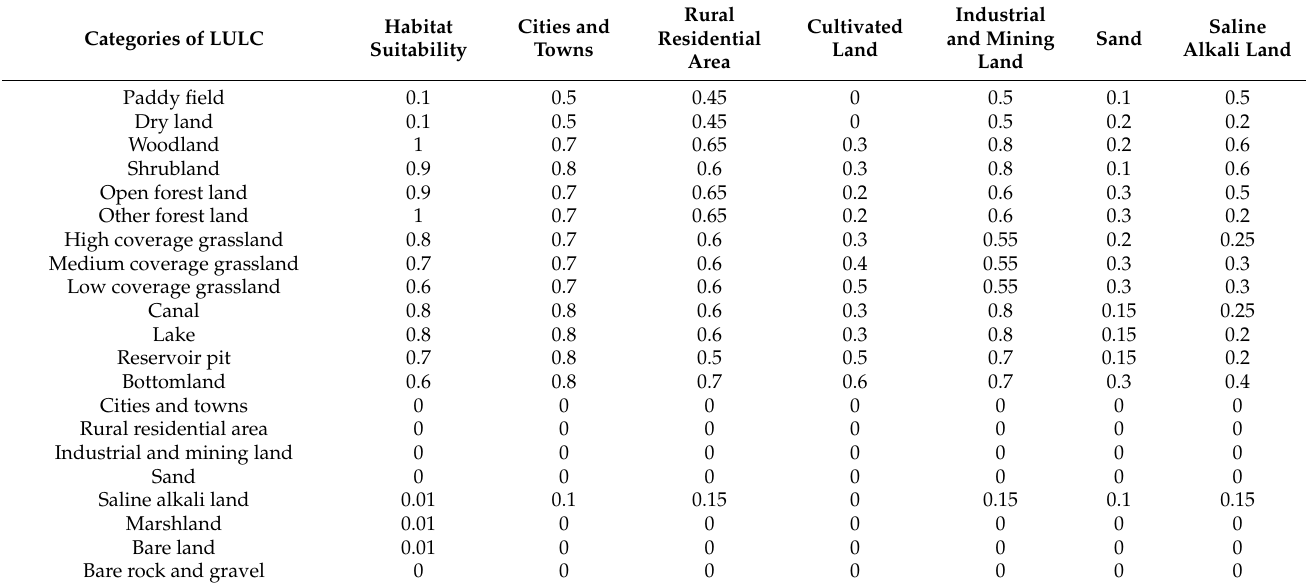
Table 5. Habitat suitability and its relative sensitivity to different threat